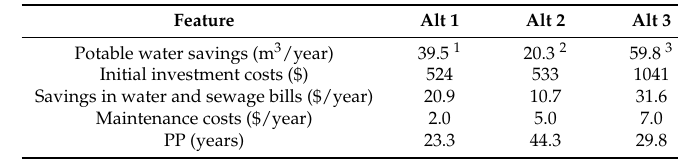
Table 8. Synthesis of the financial information on alternative RWH/GWR systems presented to